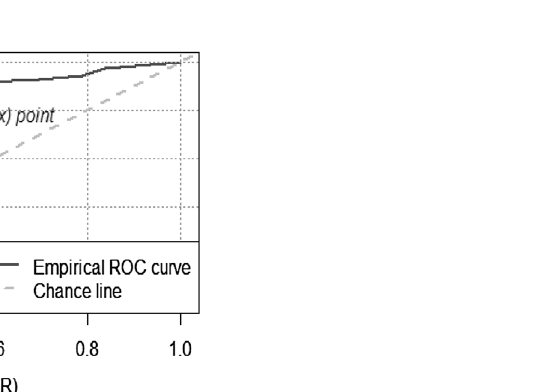
Table 3. Reliability analysis result of individual dietary diversity measurement tool of PLHIV in all Bahir Dar ART clinics, 2017.